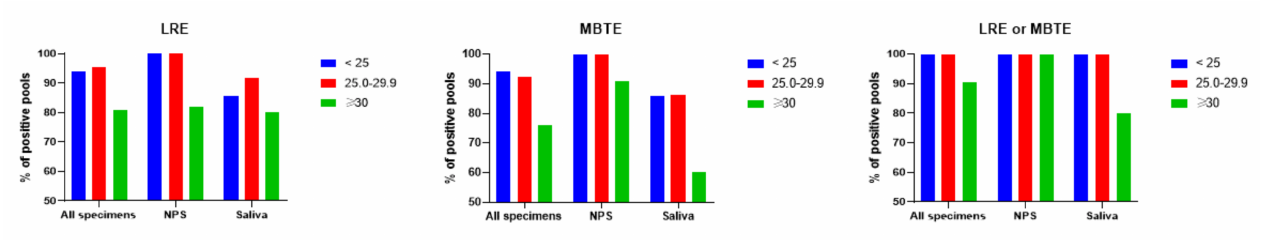
Figure 2. Comparison of SARS-CoV-2 RT-PCR positive rates between different Ct values. Different color bars indicate different Ct values. Abbreviations: LRE, liquid-based RNA extraction; MBTE, magnetic bead-based total nucleic acid extraction; NPS, nasopharyngeal